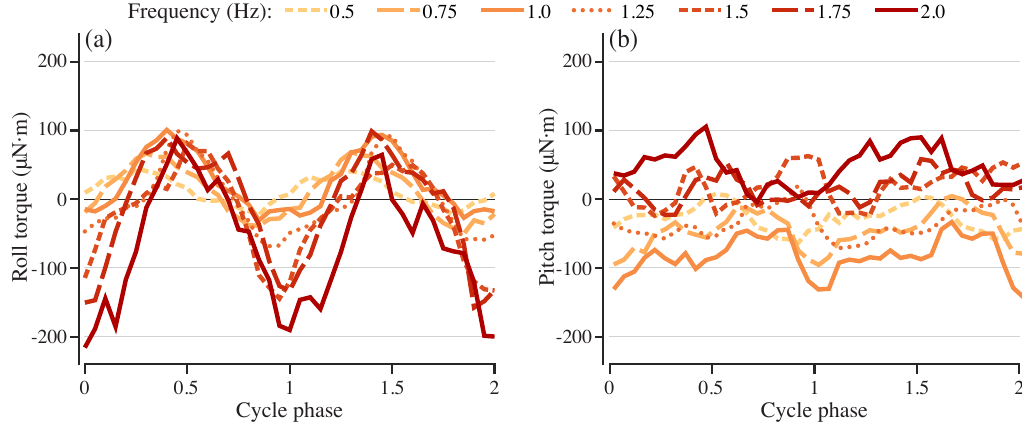
Figure 5. Pitch and roll torques needed to stabilize models with different driving frequencies. Roll ( a ) and pitch ( b ) torque for stabilization for swimmers with driving frequencies from 0.5 to 2.0